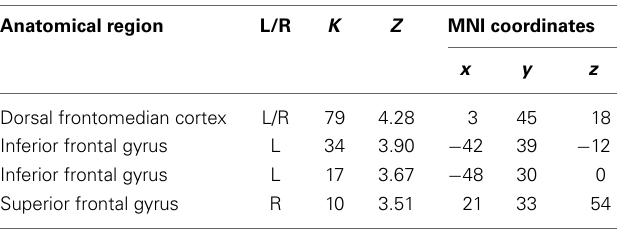
Table 3 | Brain regions revealed by the parametric whole brain analysis on the contrast Intentional Inhibition > Intentional Action (White NoGo > White Go) (thresholded p < 0 . 001 uncorrected, > 10 voxels).